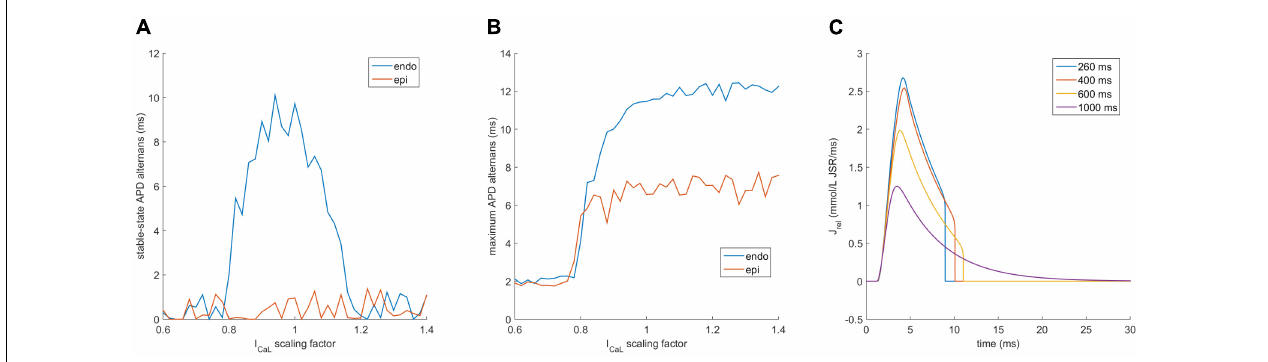
FIGURE 9 | Alternans with varied I CaL conductance in the ORd model. (A,B) are an analogy of Figures 8A,B obtained using the ORd model paced at 260 ms bcl, showing the data for both endocardial (endo) and epicardial (epi) variant, (C) shows traces of J rel in the epicardial variant of ORd after 2500 pre-pacing beats at four different base cycle lengths. The fluctuation in APD alternans amplitude in panels (A,B) are due to a higher APD variability of the ORd model at rapid pacing, compared to